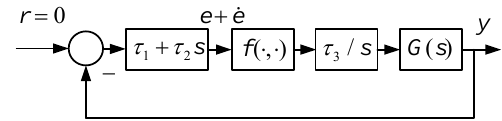
Fig. 5. Equivalent structure of the system in Fig. 1.